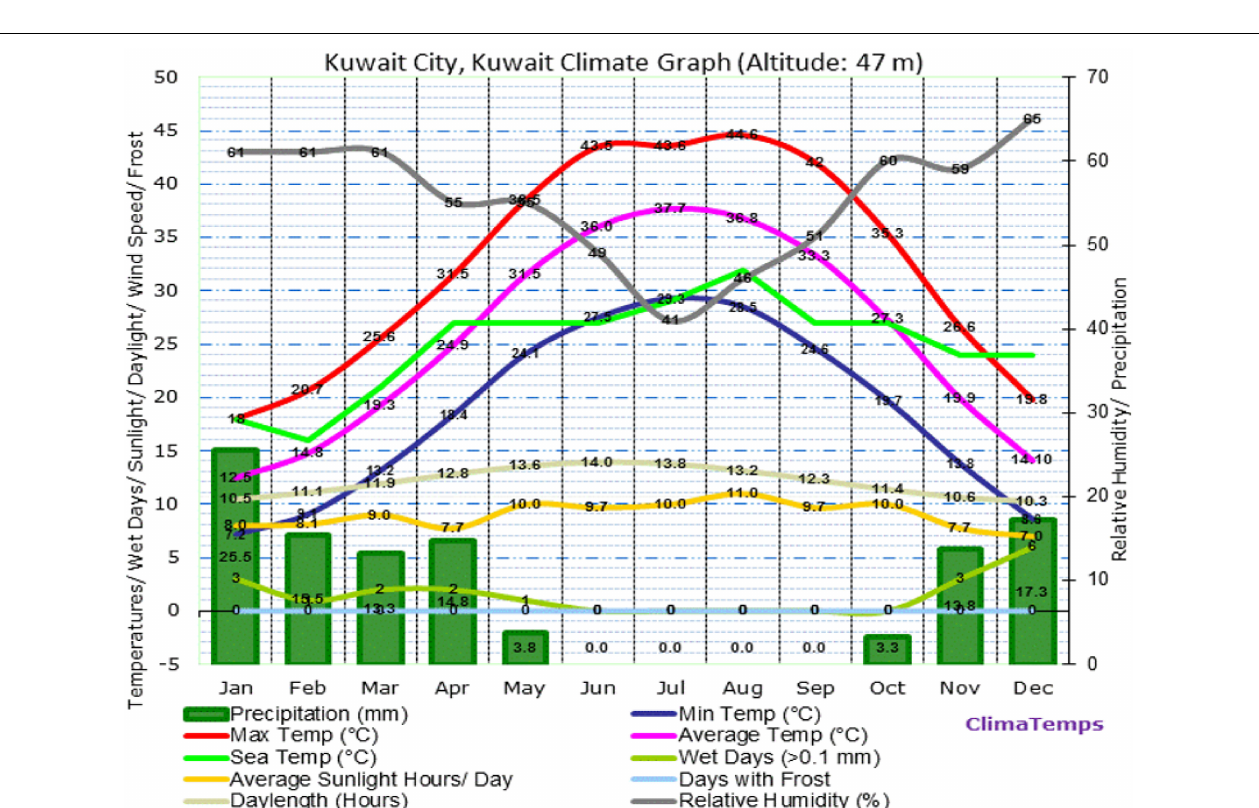
FIGURE 2 | Annual climate condition of Kuwait (ClimaTempts.com,